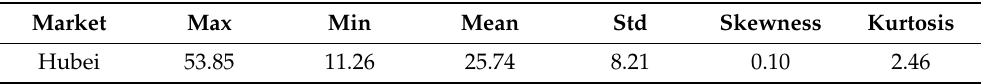
Table 1. Descriptive statistics of the carbon price.